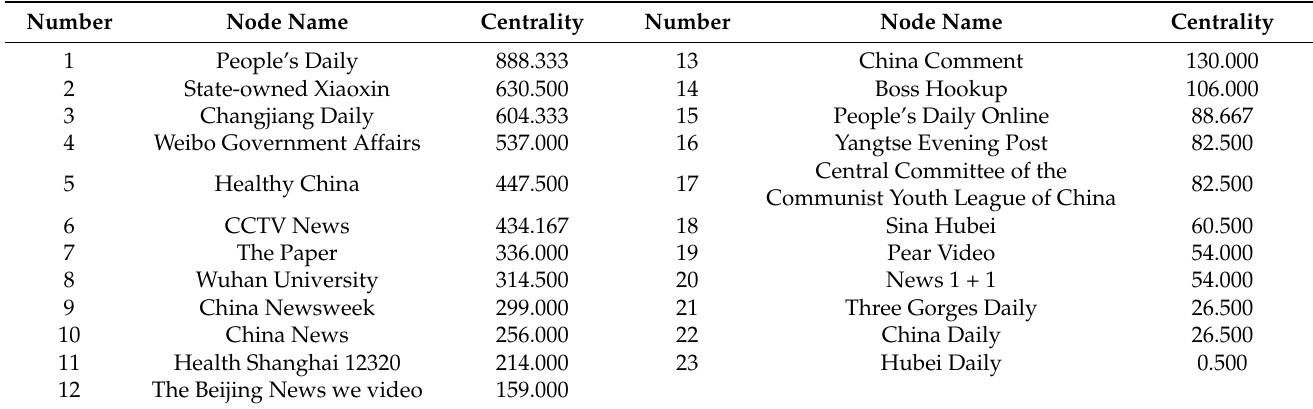
Table 3. Propagation node centrality analysis